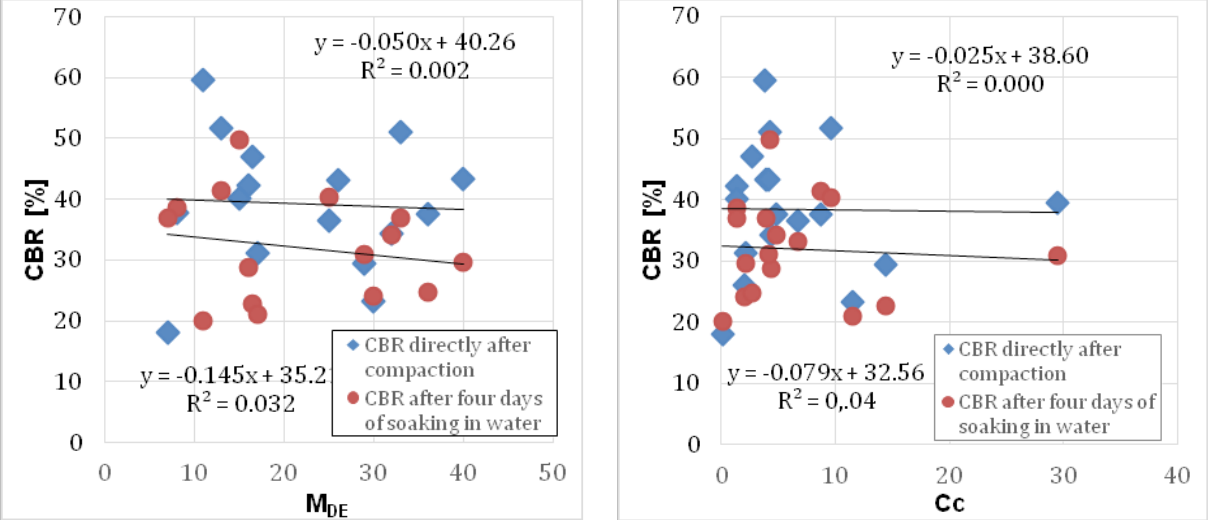
Figure 4: Correlation between CBR and micro Deval coefficient, values.